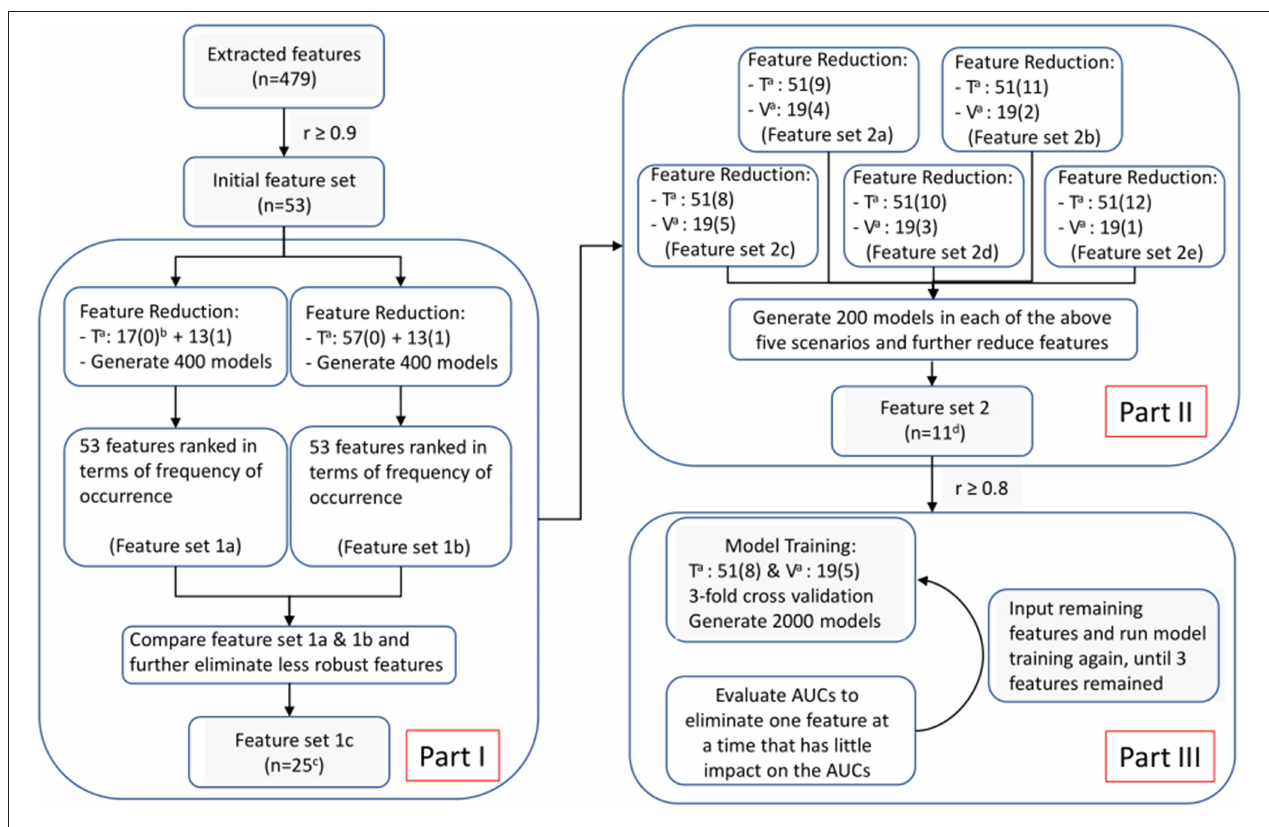
FIGURE 4 | Feature selection and model optimization methodology. Superscript “a”: T for training cohort; V for validation cohort. “b”: The number inside the parentheses is either “1” or “0,” representing “re-planned” and “not re-planned” patients; Numbers in front of the parentheses indicate number of patients. “c”: 25 features remained in feature set 1c for CET1-w-based model; while 28 and 39 for T2-w-based and Joint T1-T2-based models, respectively. “d”: 16 features remained in feature set 2 for CET1-w-beased model; while 13 and 22 for T2-w-based and Joint T1-T2-based models,